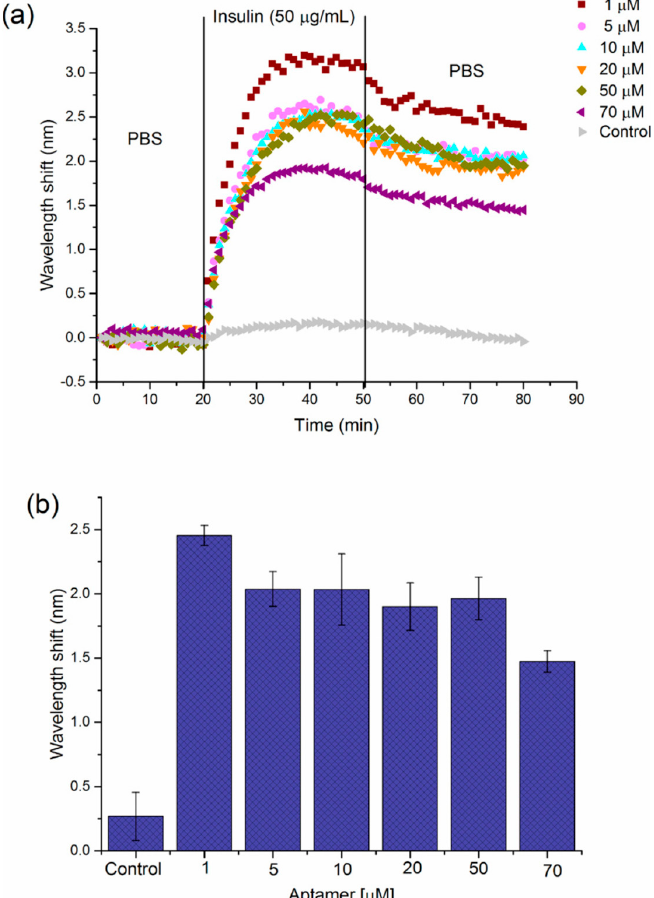
Figure 5. ( a ) Sensograms showing the effect of IBA solution concentration used for modified-PSi device on the response to 50 µ g / mL insulin. ( b ) Graph representing the average wavelength shift (nm) obtained for detection of 50 µ g / mL insulin by PSi-5 cycles surface, which is modified with a range of aptamer concentrations (1–70 μ M). Error bars correspond to the standard deviation from three individual experiments on PSi-devices prepared with each IBA concentration. Reproduced with permission from [64].